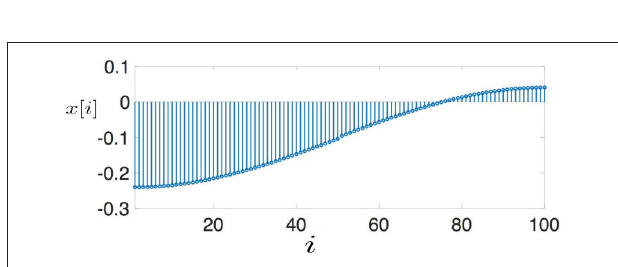
FIGURE 3 | The magnitudes of the GFT coefficients ˜ x [ l ] (cf. Equation 8) of a clustered graph signal x 0 [ · ] defined over a chain graph (cf. Figure 2 ).